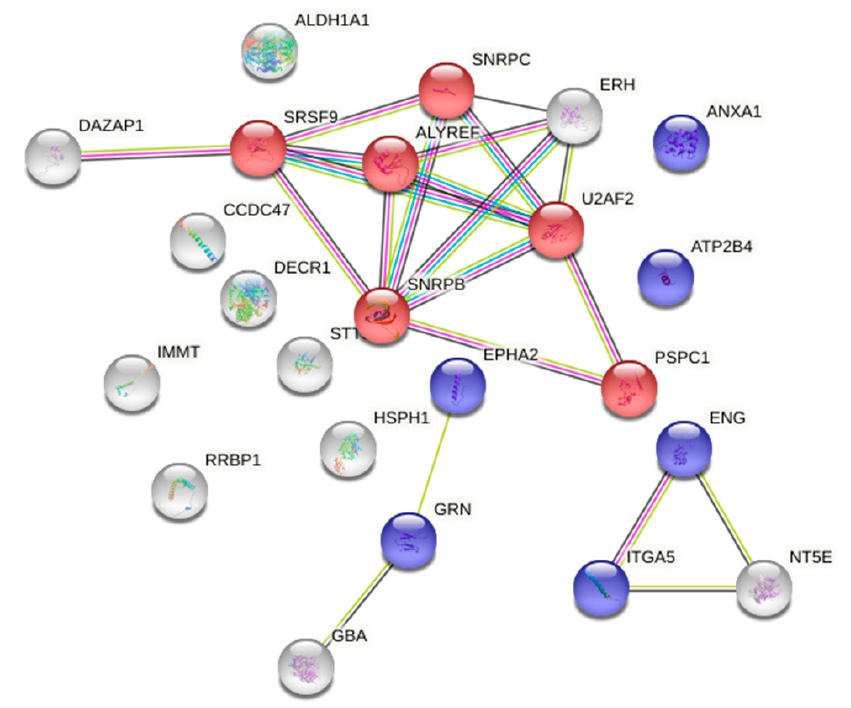
Figure 1. Gene ontology (GO) analysis of the more expressed proteins in PTX3-silenced ECs (as shown in Table 2). String network generated with these proteins that highlights the following enriched biological processes: red, mRNA splicing; blue, regulation of angiogenesis.